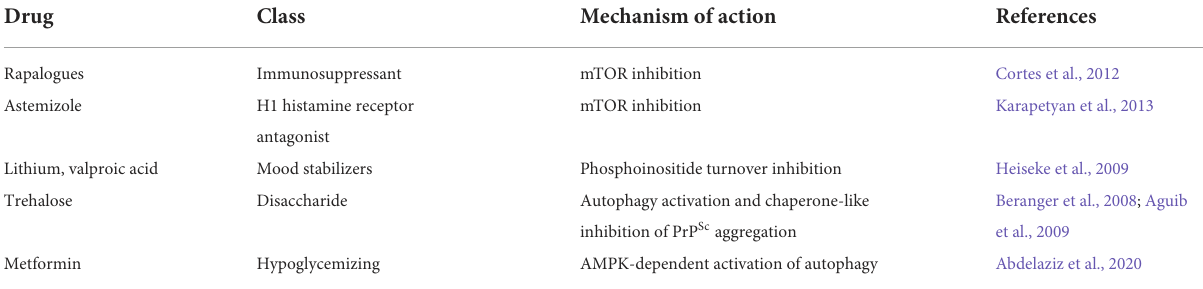
TABLE 1 Preclinical anti-prion activity of autophagy